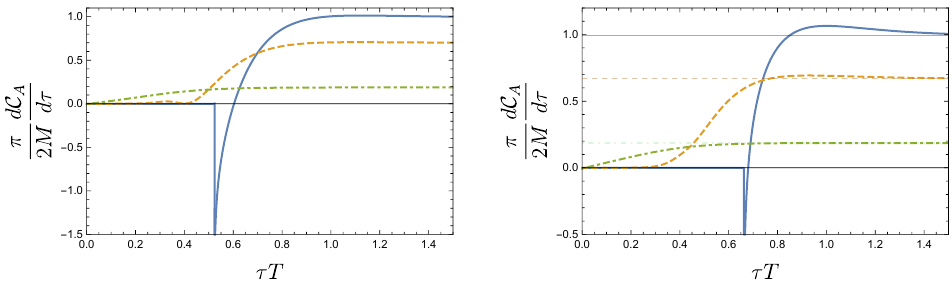
Figure 10 . The time derivative of complexity with d = 4, k = 1 and non-zero chemical potential, obtained by (cid:12)xing the parameters in eq. (4.29). The various curves correspond to: (cid:23) = 0 : 1 in blue (solid) , (cid:23) = 1 in orange (dashed) and (cid:23) = 5 in green (dot-dashed) for TR = 1 (Left) and TR = 1 (Right). In order to illustrate the violation of the bound, we explicitly show the late time limit from eq. (4.28) in the right